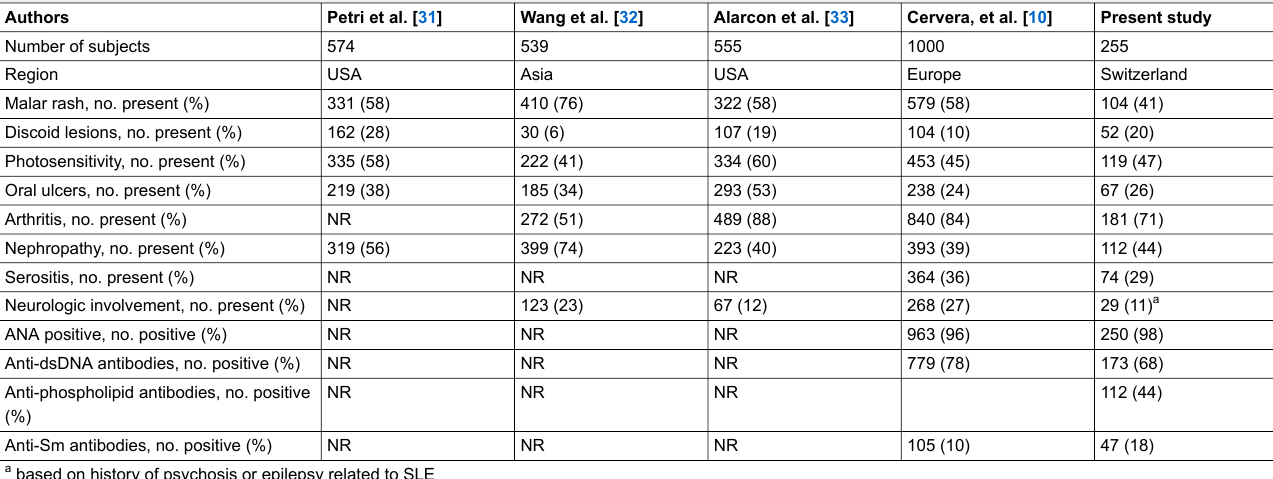
Table 4: Treatment in 255 patients with systemic lupus erythematosus. Medication Used during past month and before Systemic corticosteroids, no. (%) 116/244 (48) Oral daily prednisone equivalent at study visit, mean ± SD (range),